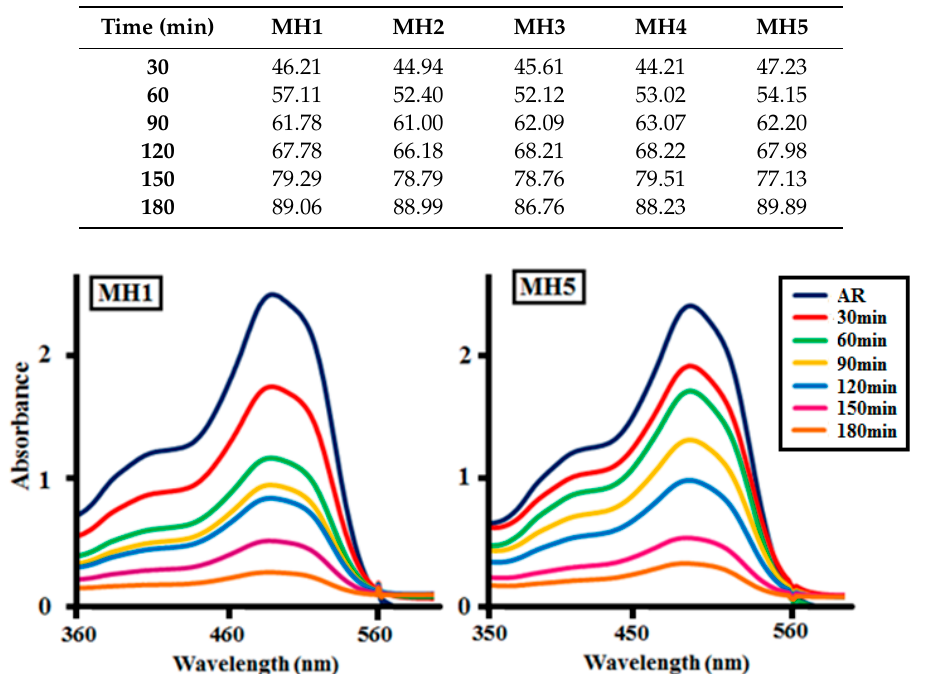
Figure 4. Photocatalytic degradation of alizarin red (AR) dye (250 ppm) at different time intervals by 0.025 g of MH1 and MH5.